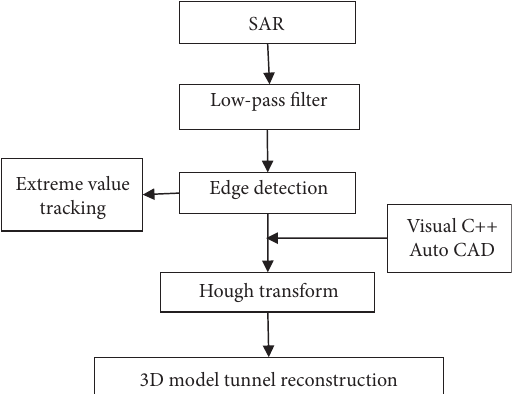
Figure 7: Procedure for tunnel reconstruction.